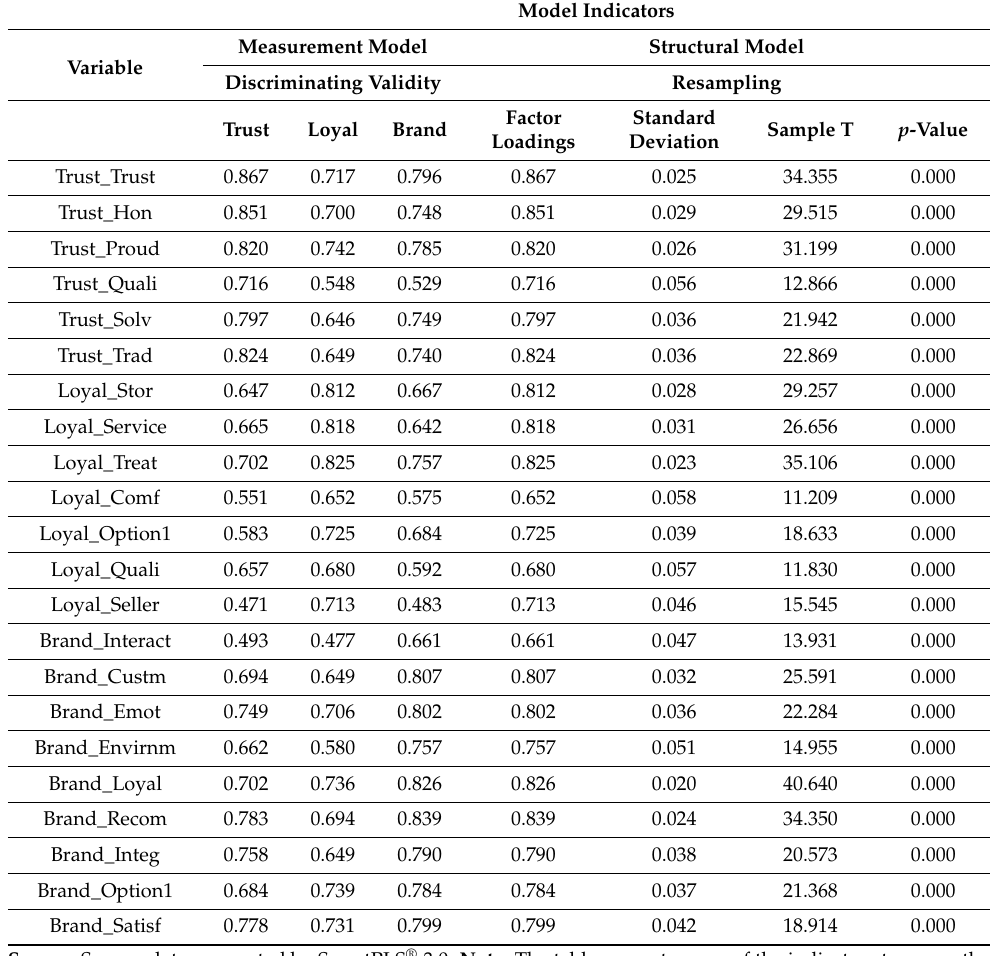
Table 3. Discriminant validity and factor loads of the observed variables.